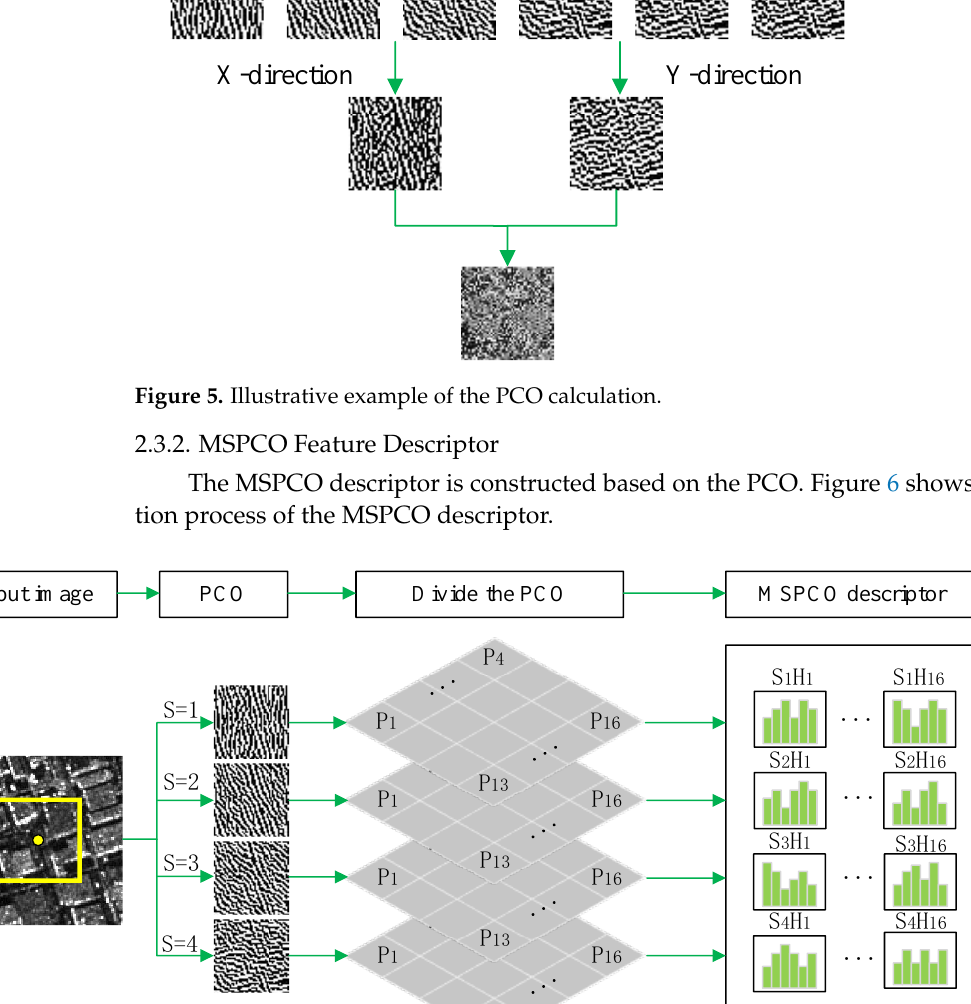
Figure 6. Main processing chain of the proposed MSPCO descriptor.